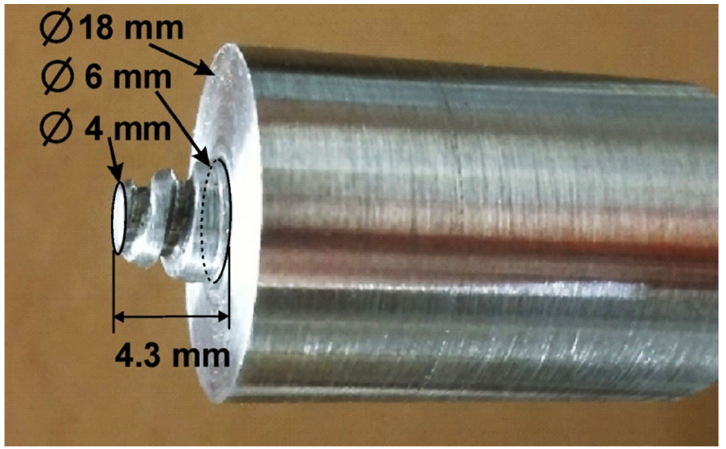
Figure 1. Tool used in friction stir processing of 7075 aluminum alloy.